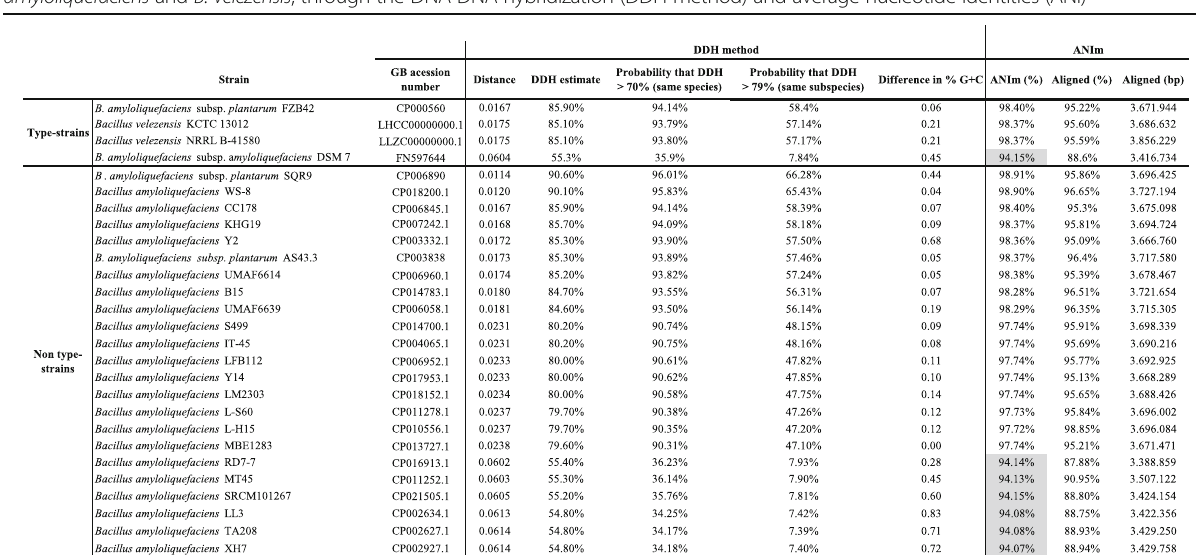
Table 6 Comparative analysis of the in-silico genome distances between B. amyloliquefaciens subsp. plantarum strain Fito_F321 withboth B. amyloliquefaciens and B. velezensis , through the DNA-DNA hybridization (DDH method) and average nucleotide identities (ANI)